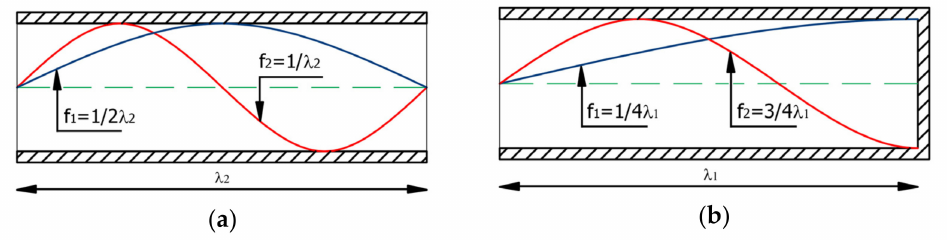
Figure 3. Standing wave distribution for the first and second resonant frequencies in an open tube ( a ) and a closed-end tube ( b